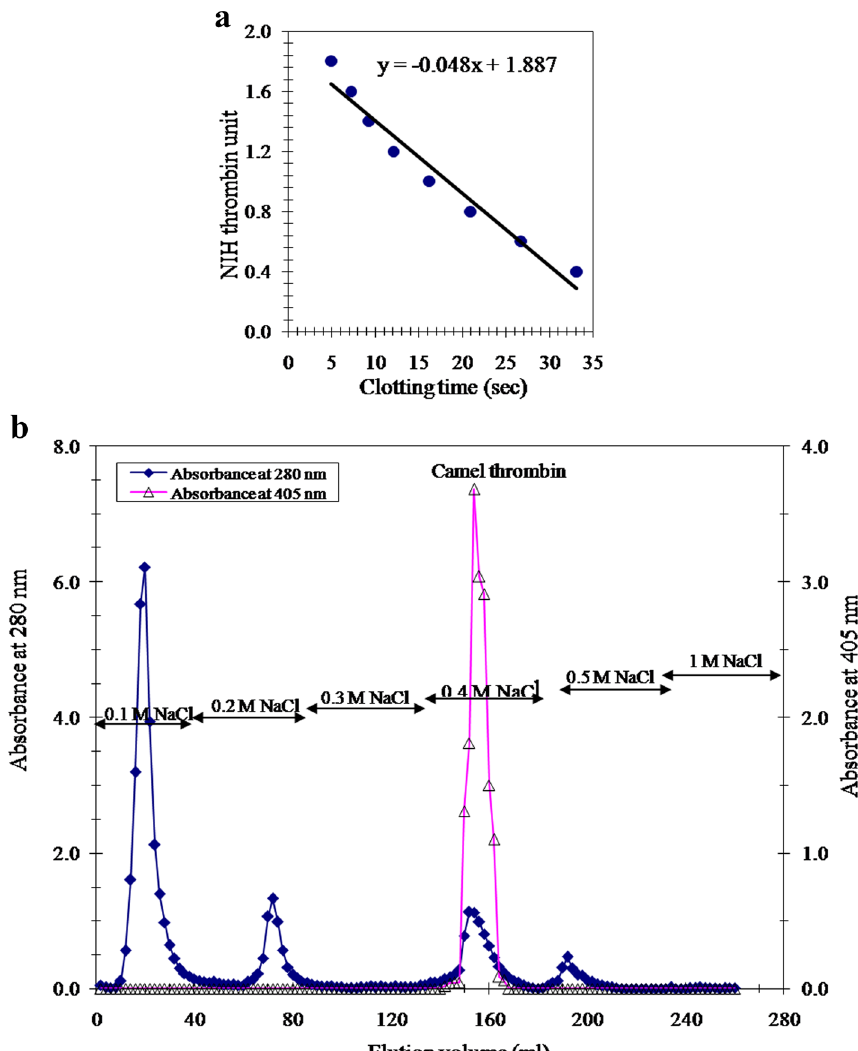
Fig. 1 a Thrombin clotting time calibration curve. Clotting time is plotted against National Institute of Health (NIH) units of bovine thrombin. b A typical elution profile for the affinity chromatography of camel thrombin on heparin-agarose column (8